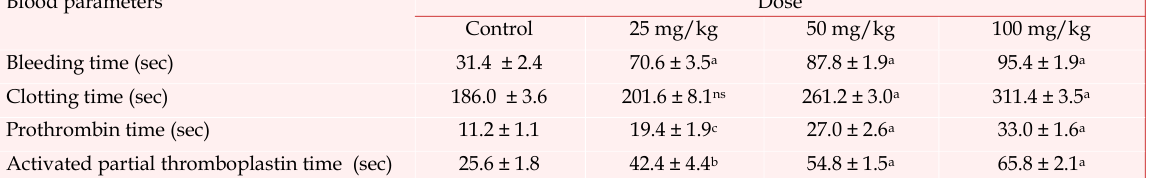
Effect of aqueous methanolic extract on different blood coagulation parameters after seven days of treatment Blood parameters